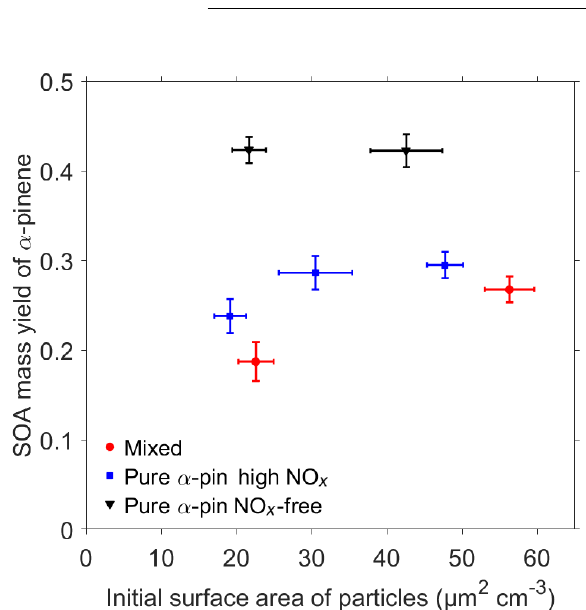
Figure 5. α -Pinene SOA mass yield as a function of initial surface area of particles from all experiments. Error bars for the x axis are estimated from the scatter in measurements of surface area of par- ticles monitored by SMPS and for the y axis from uncertainties in SP-AMS and PTR-ToF-MS measurements using square root of sum of squares of relative standard